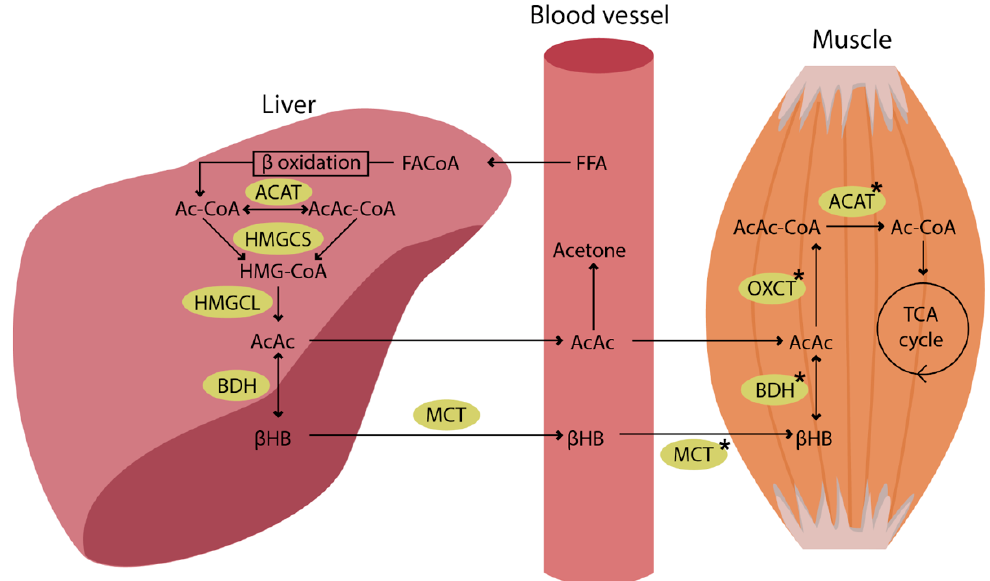
Figure 1. Ketogenesis in the liver and ketolysis in the muscle (for details see [14]). FFAs are transported to the liver and converted to fatty acyl CoA (FA-CoA). The next step after β -oxidation is condensation of Ac-CoA molecules to acetoacetyl CoA (AcAc-CoA) by mitochondrial thiolase activity of Ac-CoA acetyltransferase (ACAT). Then, in a reaction with hydroxymethylglutaryl CoA synthase (HMGCS) generates hydroxymethylglutaryl-CoA (HMG-CoA). HMG-CoA decomposes to AcAc by HMG-CoA lyase (HMGCL). AcAc can be released to the circulation, but most of it is reduced to β HB by 3-hydroxybutyrate dehydrogenase (BDH). β HB can undergo interconversion with AcAc in the liver and in other tissues after its uptake from the blood. Succinyl-CoA:3-oxoacid CoA transferase (OXCT) catalyses the generation of AcAc-CoA from AcAc and succinyl-CoA. Fi- nally, AcAc-CoA is cleaved to Ac-CoA by ACAT, and Ac-CoA is incorporated into the TCA cycle. The asterisk (*) indicates protein content and enzyme activity that are higher in the exercise-trained skeletal muscle.